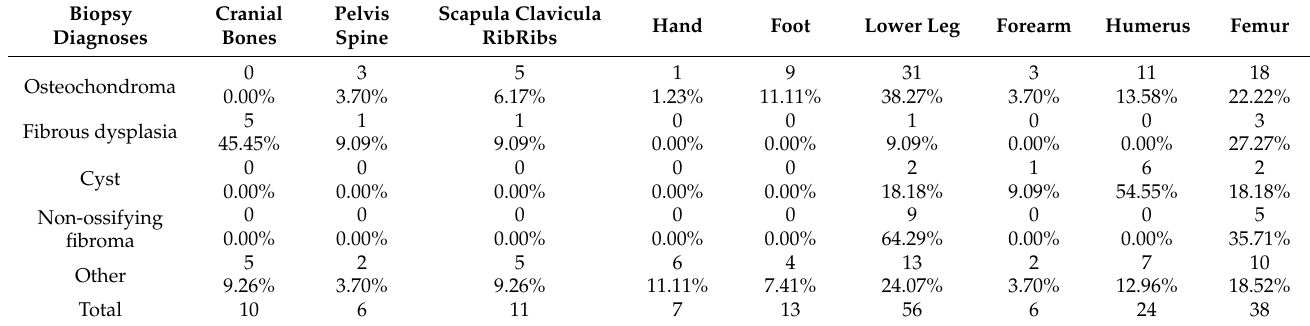
Table 3. Locations of lesions in the skeleton.